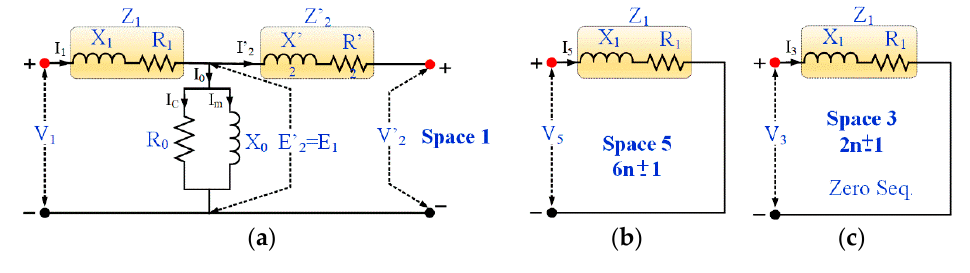
Figure 11. Equivalent circuit of single-phase transformer.